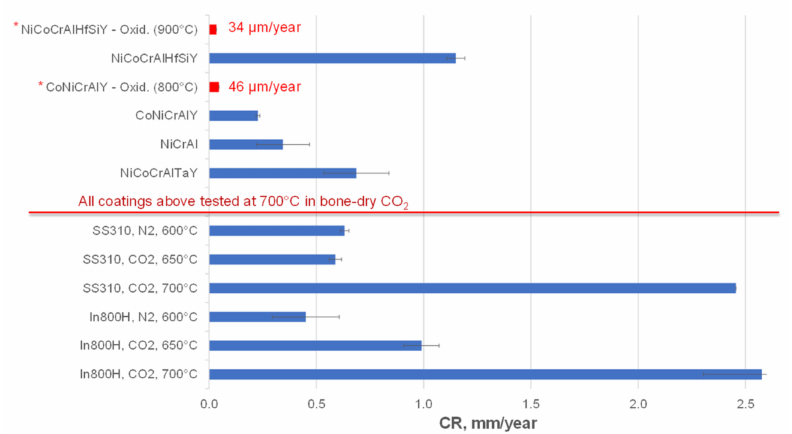
Figure 12. Corrosion rates of bare and coated alloys in Na 2 CO 3 –K 2 CO 3 –Li 2 CO 3 in bone-dry CO 2 and N 2 atmospheres, reproduced from [113], with permission of Elsevier